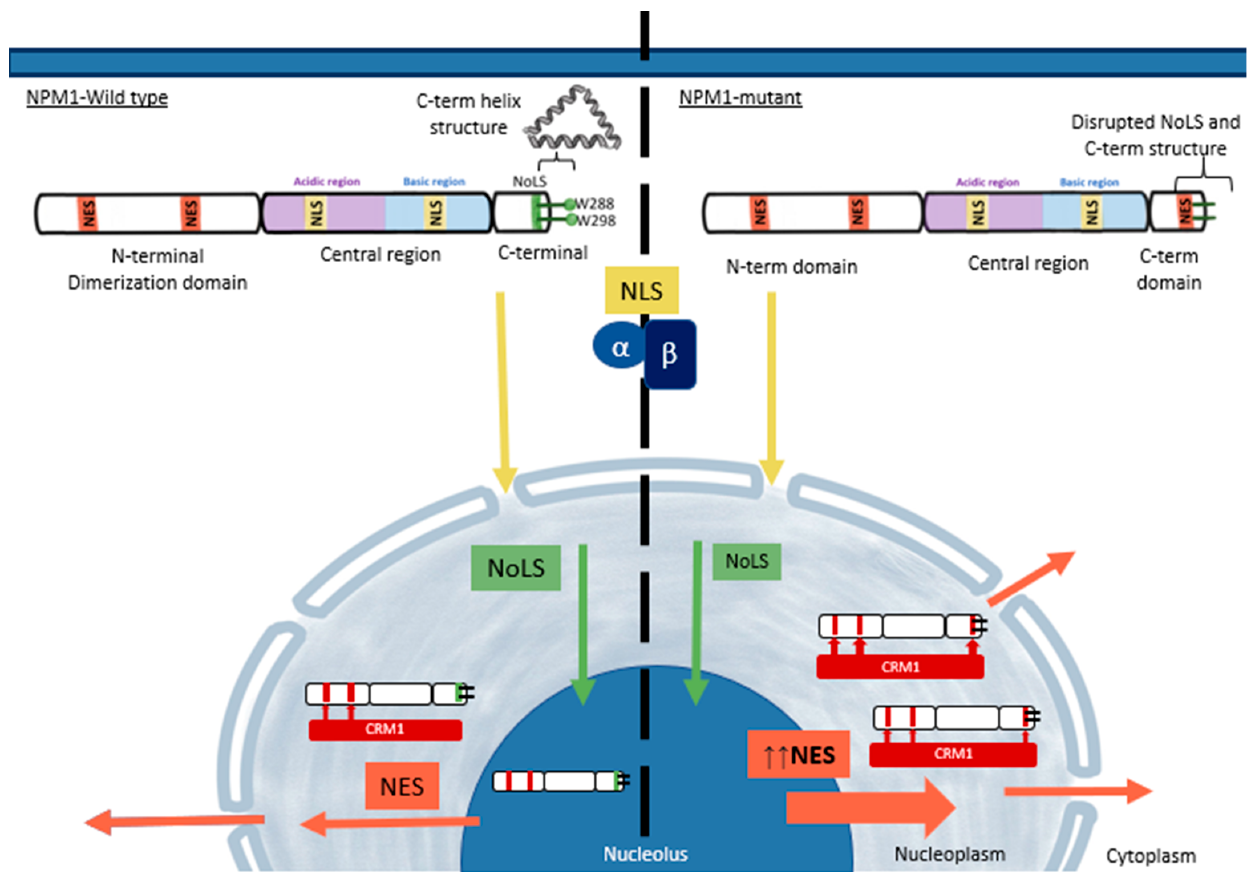
Figure 2. NPM1 wild-type protein, and NPM1-mutant protein structural influences in nucleo-cytoplasmic relocation. Acidic regions influence binding to histone proteins, NLS: nuclear localisation signal binds to importin alpha and beta causing nuclear localisation, NoLS: Nucleolar localisation signals transport NPM1 to the nucleolus, W288, W298: Tryptophan stabilises NoLS and form a C-term helix structure, NES: Nuclear export signals interact with XPO1/CRM1 (chromosomal maintenance 1) protein resulting in an increase in cytoplasmic NPM1.